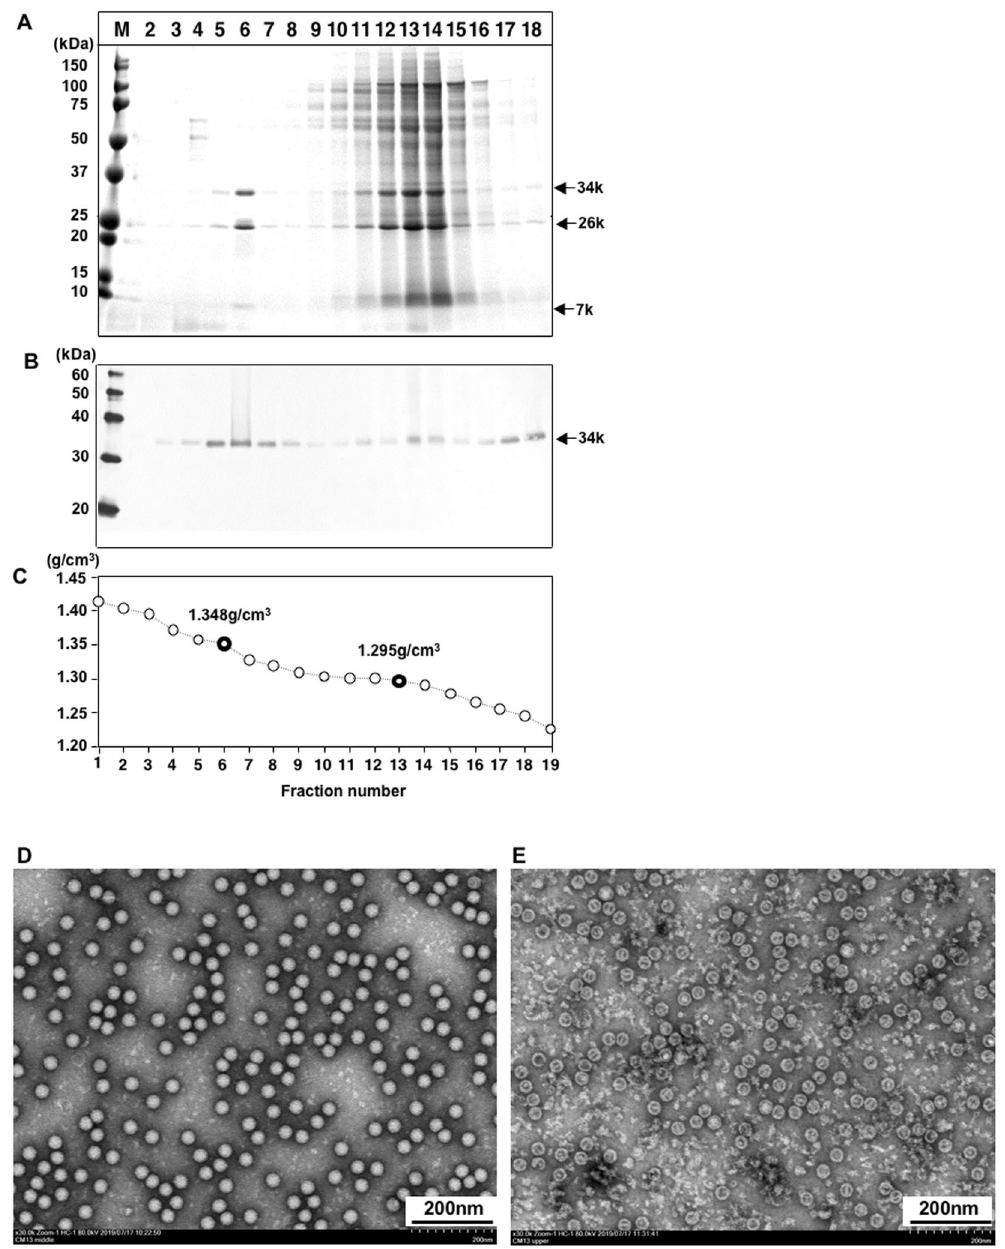
Figure 1. Purification of CPE agent (s). The supernatant of the infected PLC/PRF/5 cells was concentrated by ultracentrifugation, and further purified by CsCl gradient centrifugation. Aliquots from each fraction were analyzed by 5%–20% SDS-PAGE. Proteins were visualized by Coomassie blue staining ( A ) and western blotting with SSV-positive serum from Monkey C13 ( B ). The density of each fraction is shown ( C ). Virus particles in fraction 6 ( D ) and 13 ( E ) were observed by EM. Bar, 200 nm.